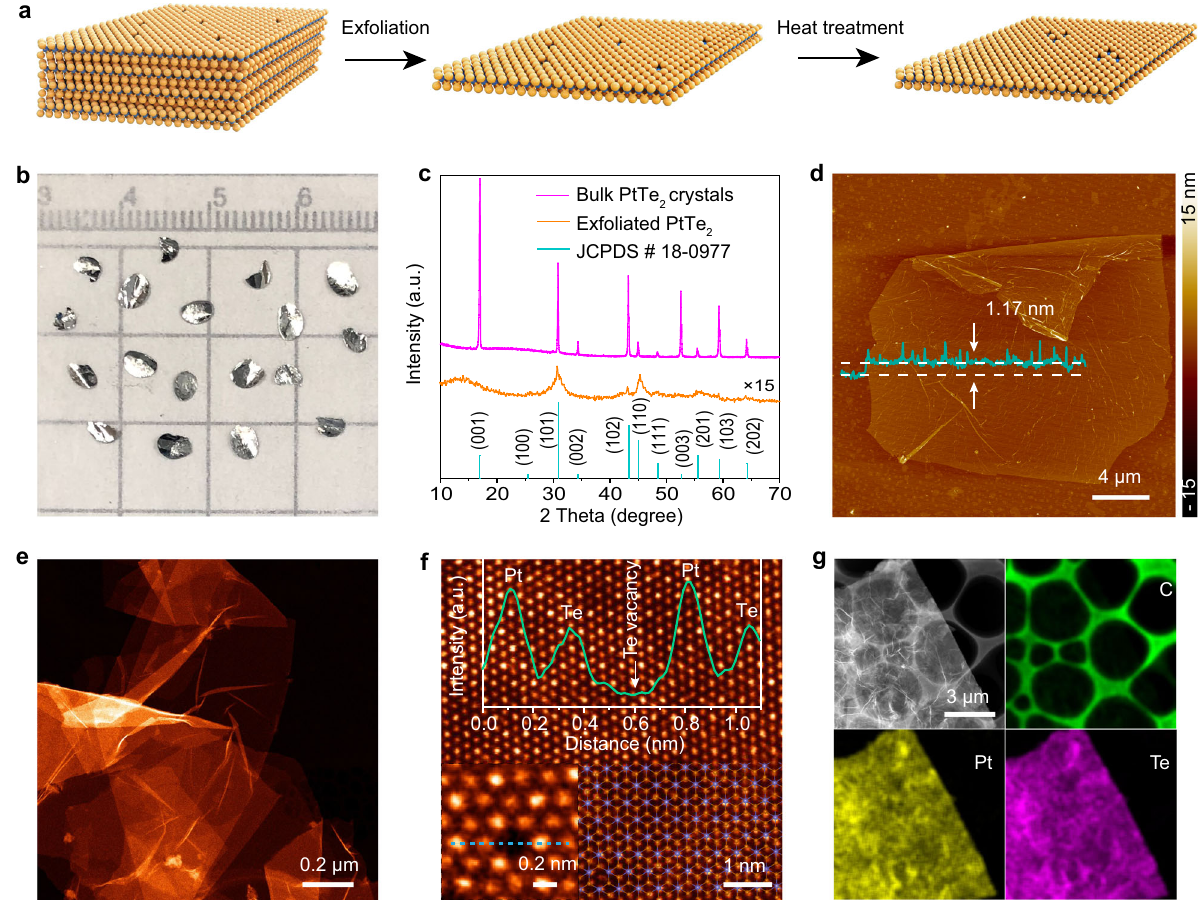
Fig. 1 Preparation and characterization of PtTe 2 NSs. a Schematic illustration showing the fabrication of atomically thin PtTe 2 NSs with different vacancy structures. b Digital photograph of the PtTe 2 crystals on a millimeter-grade paper. c XRD patterns of bulk PtTe 2 crystals and exfoliated PtTe 2 NSs. The standard XRD pattern of PtTe 2 (JCPDS # 18-0977) is shown as a reference. d AFM image of atomically thin PtTe 2 NSs. e HAADF-STEM image of few-layer PtTe 2 NSs. f High-resolution HAADF-STEM image of few-layer PtTe 2 NSs and the corresponding structural model of PtTe 2 . Inset on top shows the intensity pro fi le corresponding to the blue line. g HAADF-STEM image and the corresponding elemental mapping images of exfoliated PtTe 2